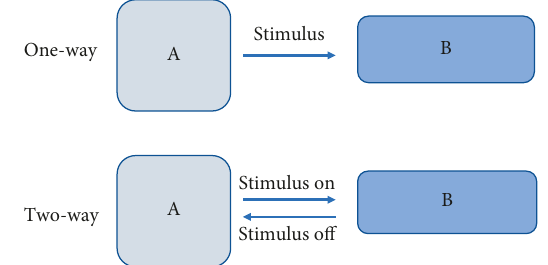
Figure 2: One-way and two-way SMPs.